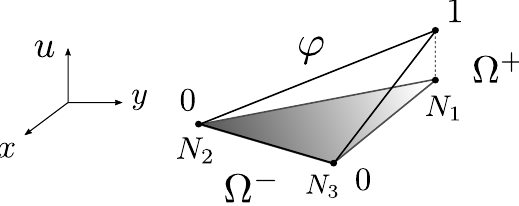
Figure 4. Example of the ϕ function for a constant stress triangle defined by the nodes N 1 , N 2 , N 3 , with node 1 on the Ω + domain and the others on Ω − . Note that for this case there is only one possible linear ϕ